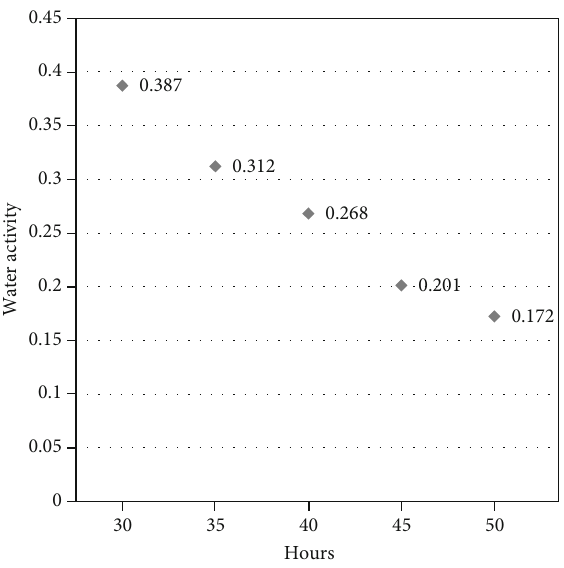
Figure 1: The graph of water activity of the instant green smoothie sample for di ff erent freeze drying